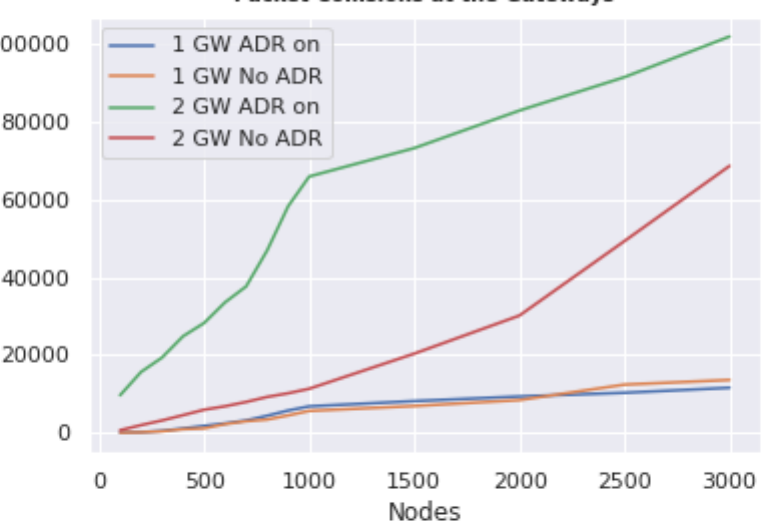
Figure 14. Packet collisions measured in all gateways of each